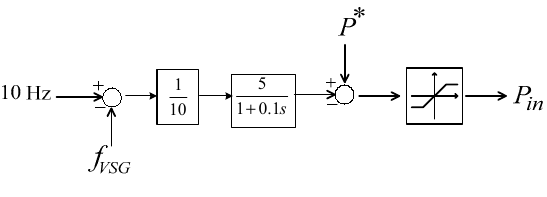
Figure 12. Governor control scheme.